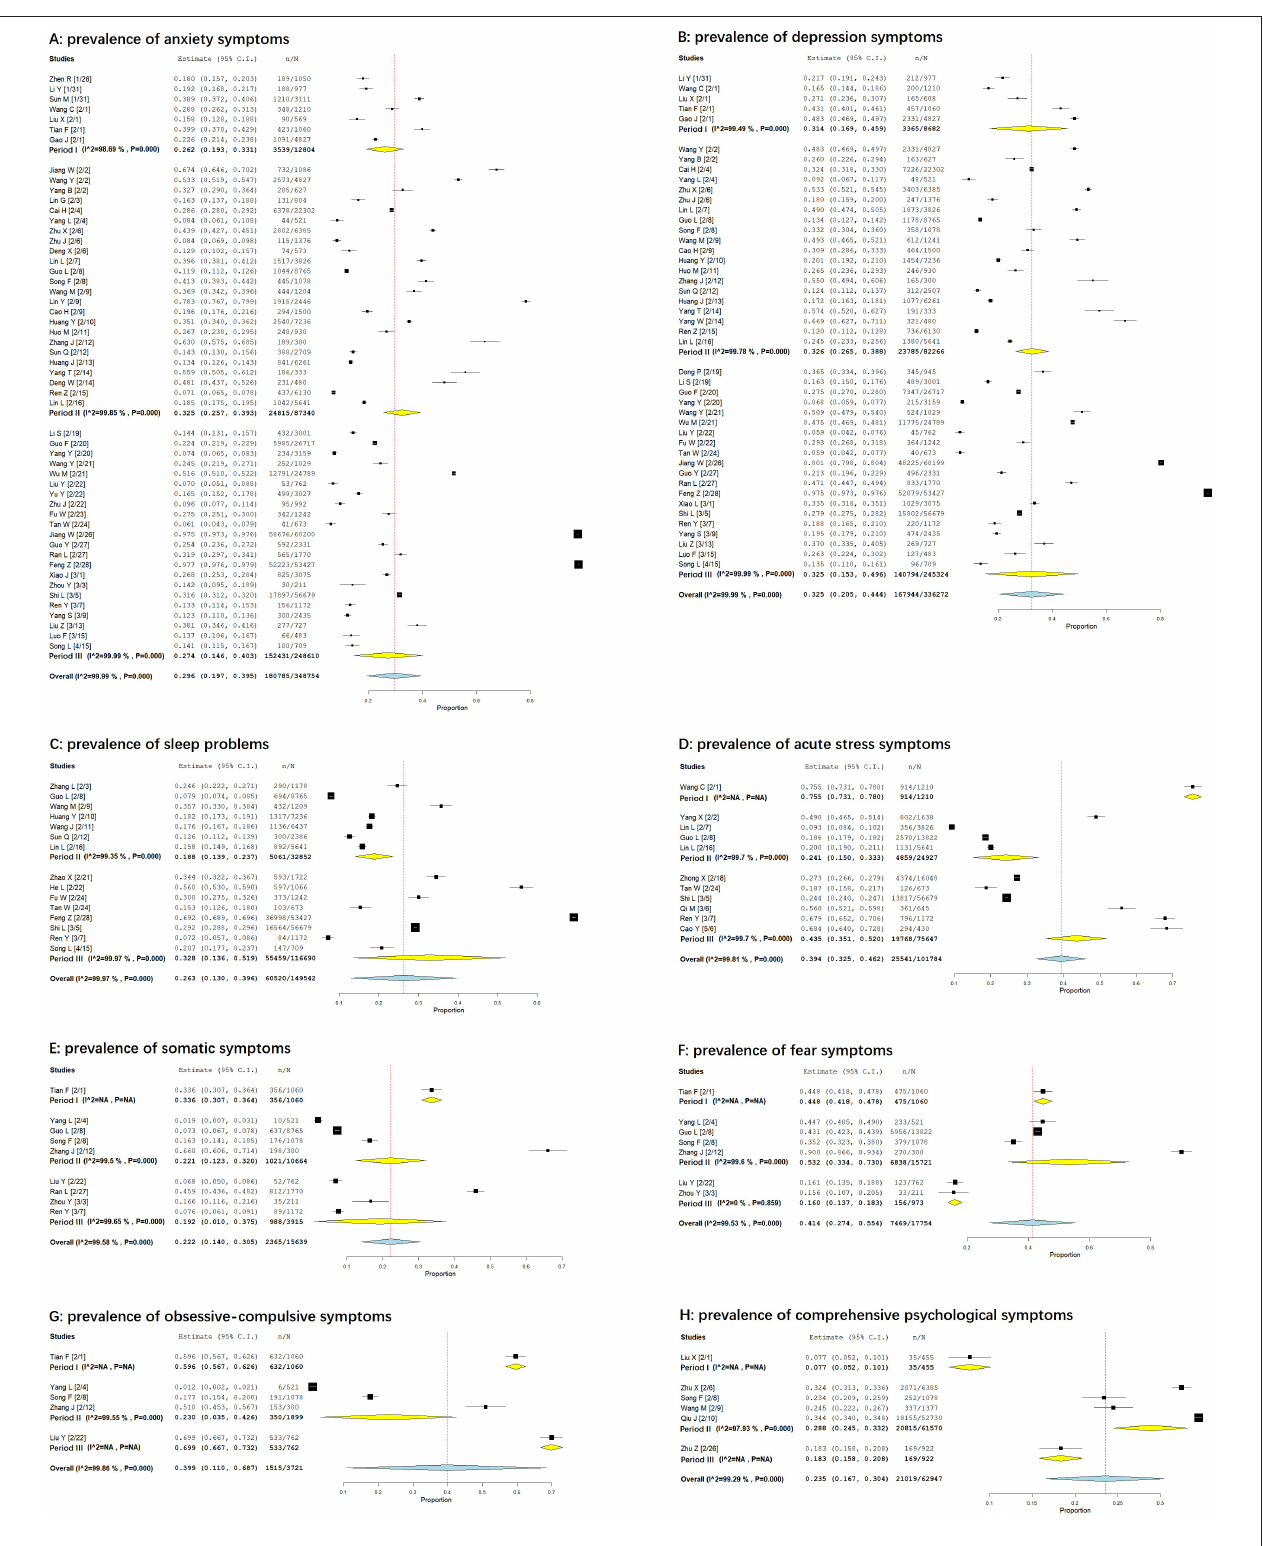
FIGURE 2 | Forest plots: the prevalence of different psychological statuses during the COVID-19 outbreak in China. [ (A) prevalence of anxiety symptoms; (B) prevalence of depression symptoms; (C) prevalence of sleep problems; (D) prevalence of acute stress symptoms; (E) prevalence of somatic symptoms; (F) prevalence of fear symptoms; (G) prevalence of obsessive-compulsive symptoms; (H) prevalence of comprehensive psychological symptoms].